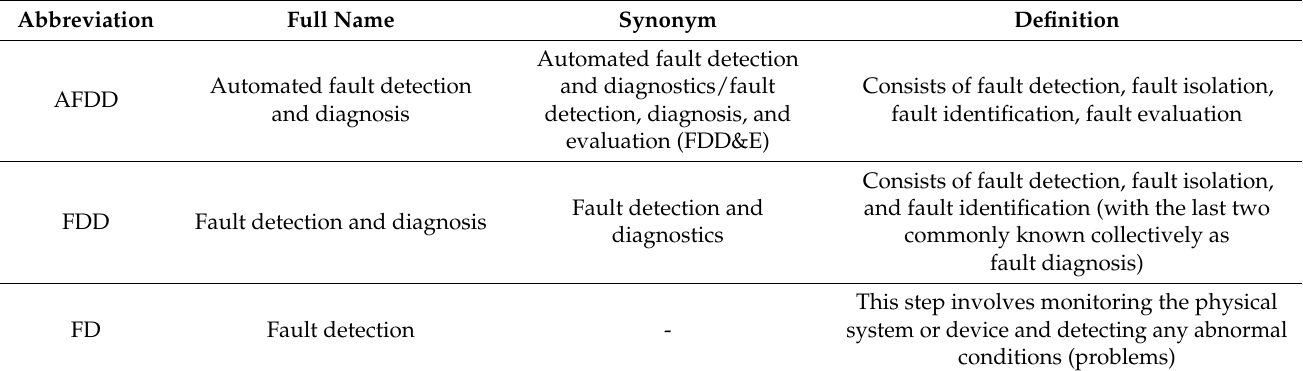
Table 2. The main nomenclature of terms frequently used for FDD in building